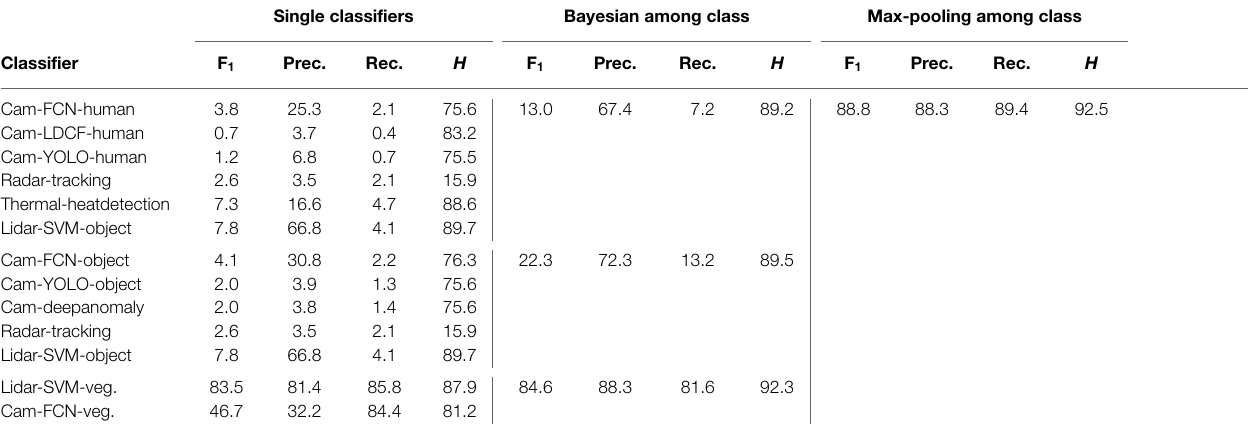
Single classifiers Bayesian among class Max-pooling among